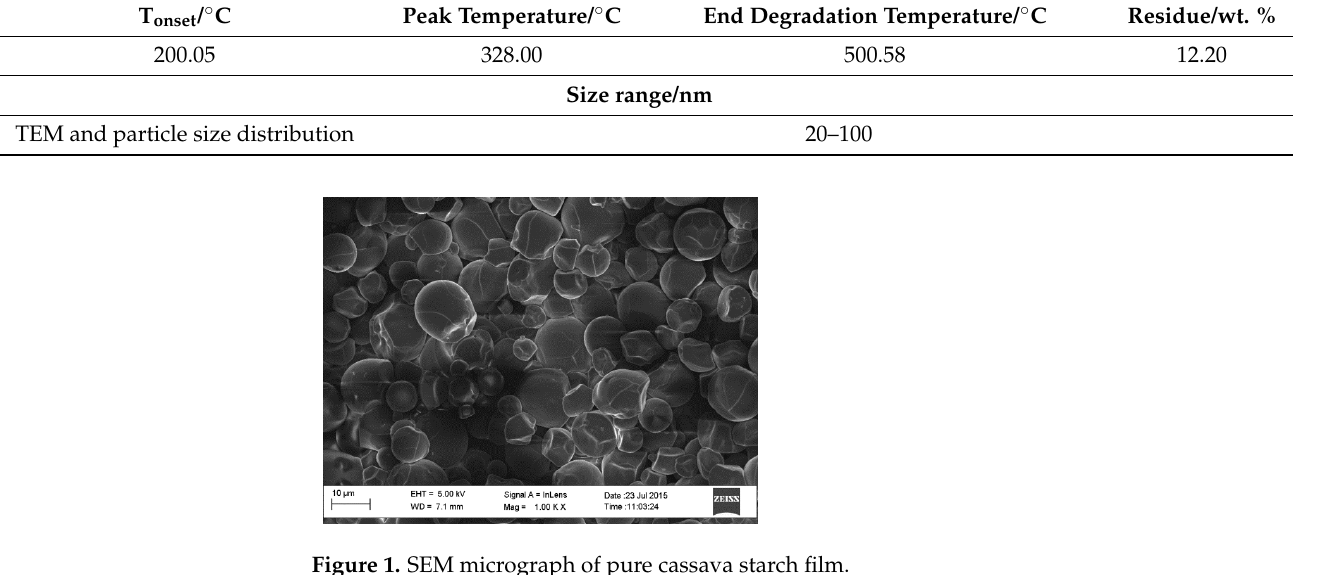
Figure 1. SEM micrograph of pure cassava starch